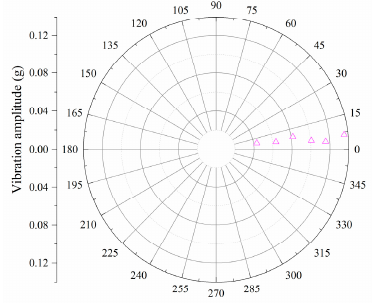
Figure 11. Lateral amplitude diagram of counterweight.